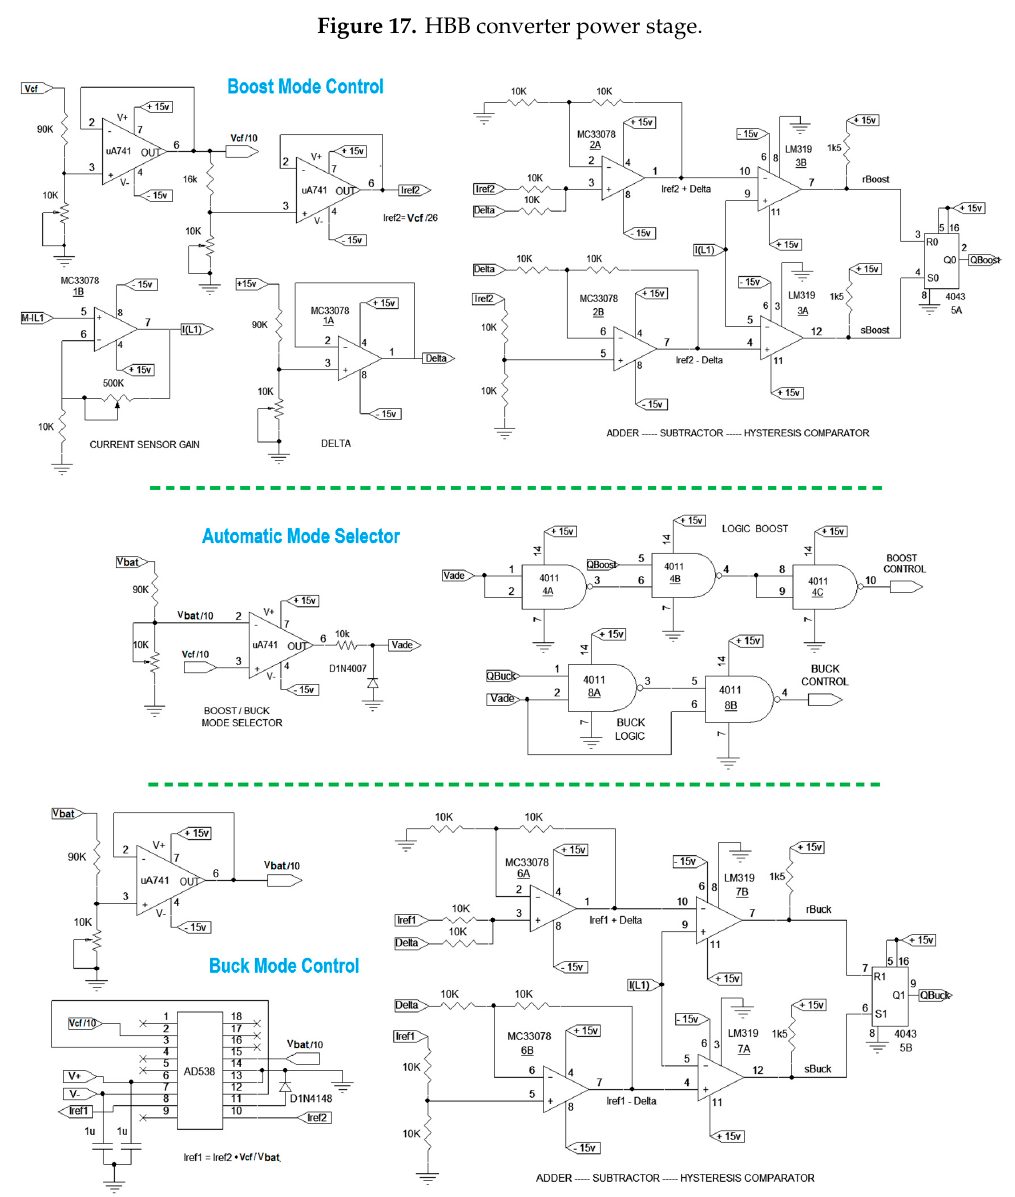
Figure 18. HBB control board.